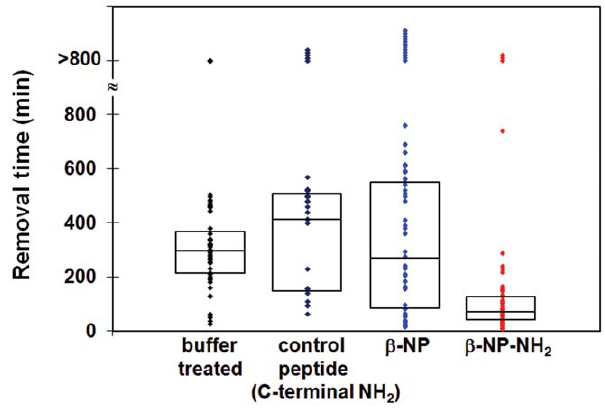
Figure 5. Movement times of dead ants treated with synthetic peptides and presented to untreated ants. Freeze-killed ants were immersed in 100 nM solution of either a control amidated peptide (QAGVTGHA-NH 2 ), b -NP (QPQFTPRL), or b -NP-NH 2 and presented to untreated ants. b -NP-NH 2 -treated ants were moved significantly faster than the control and other peptide treatments (P , 0.001).